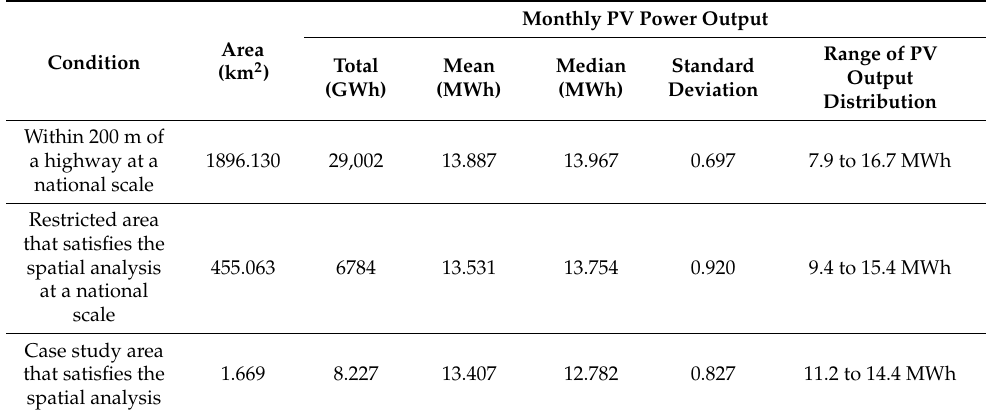
Table 2. Summary of the distribution of PV outputs potentially produced in different conditions.